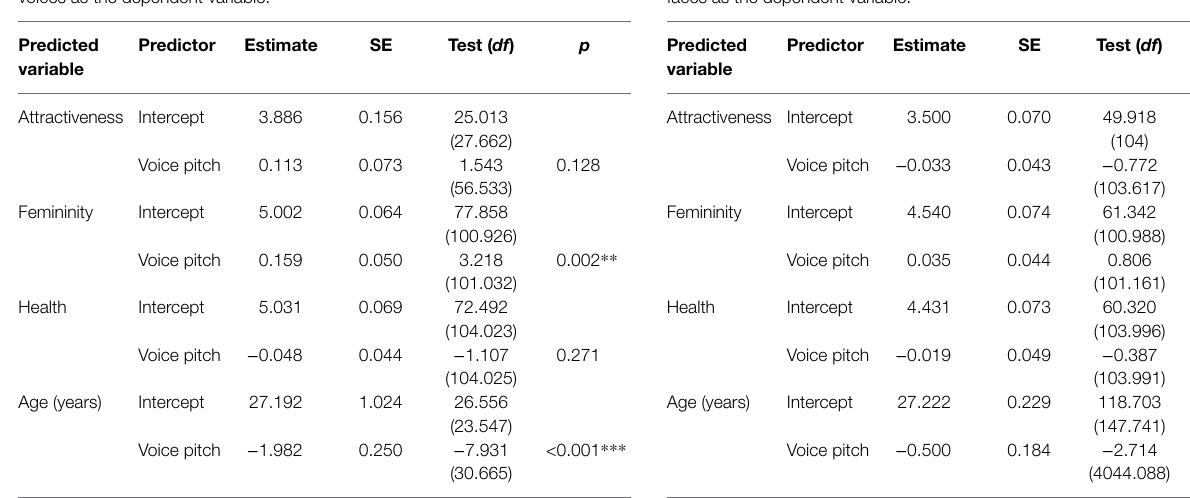
TABLE 4 | Linear mixed models with voice pitch condition (original vs. increased) as the fixed effect and ratings of attractiveness, femininity, health, and age of voices as the dependent variable.